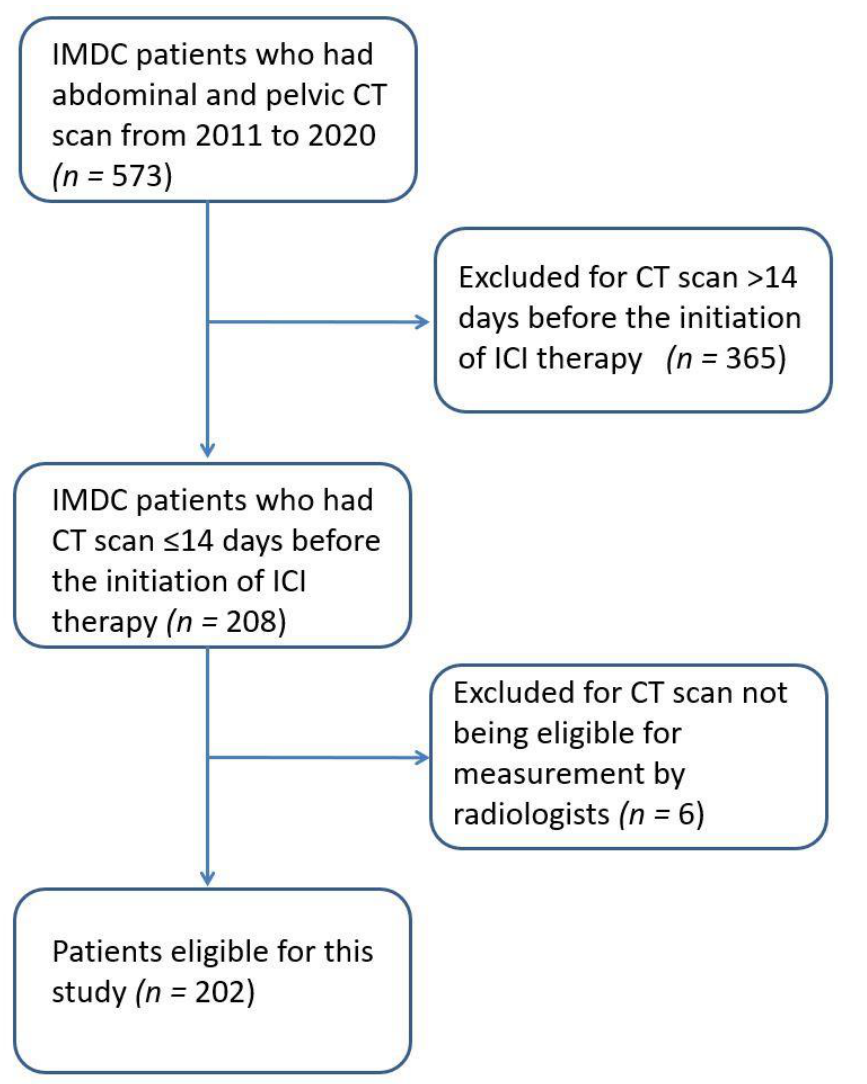
Figure 2. Patient selection flow chart.